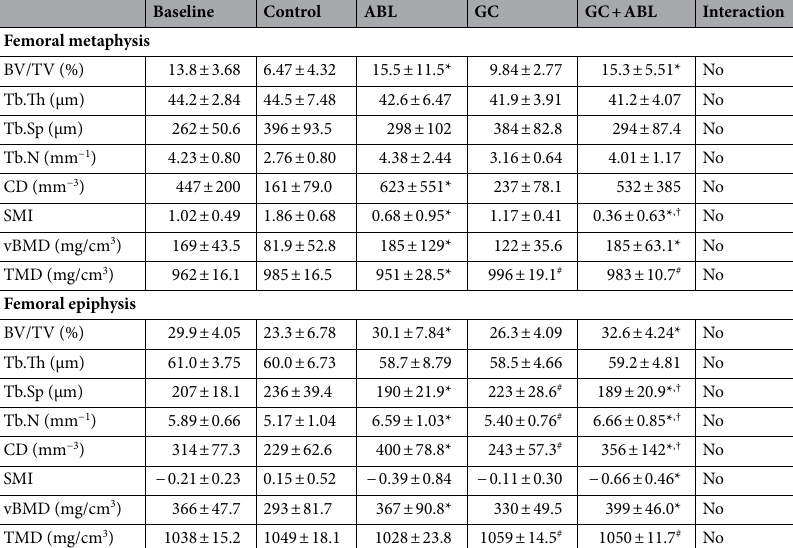
Table 3. Microstructural properties of femoral metaphyseal and epiphyseal bone of mice subjected to subcutaneous slow-release glucocorticoid (GC) pellets and treated with abaloparatide (ABL) for four weeks. BV/TV bone volume/tissue volume, Tb.Th trabecular thickness, Tb.Sp trabecular spacing, Tb.N trabecular number, CD connectivity density, SMI structure model index, vBMD volumetric bone mineral density, TMD tissue mineral density. Mean ± SD. * p < 0.05 vs. Control. # p < 0.05 vs. ABL. † p < 0.05 vs. GC.